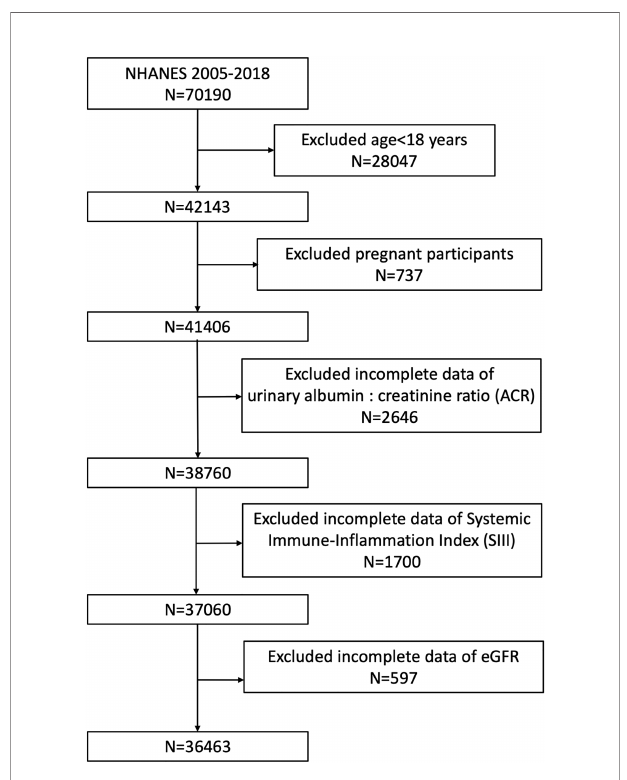
FIGURE 1 | Flowchart of the sample selection from NHANES 2005 –